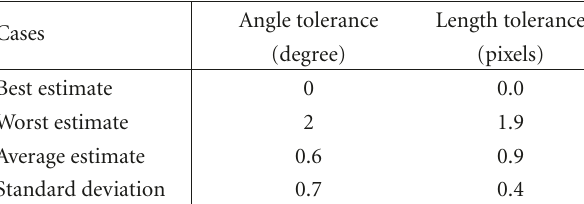
Table 1: Experimental results of our algorithm on 80 degraded standard images (256 × 256) with no additive noise.